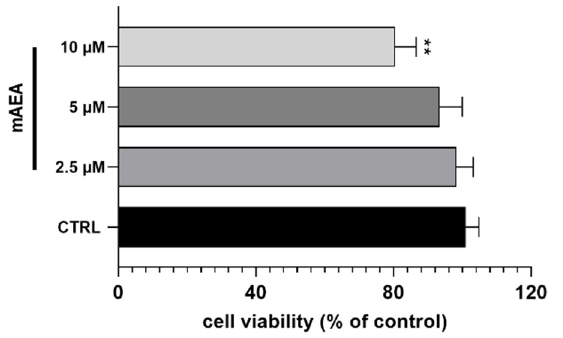
Figure 7. Assessment of cell viability using MTT assay on C2C12 myoblasts treated with mAEA at different doses (2.5, 5.0 and 10 µ M) for 24 h. Values are expressed as % of control cells and presented as mean ± SEM of three independent experiment ( n = 3). Statistical analysis was performed by ONE-WAY ANOVA followed by Bonferroni post-hoc test [** p < 0.01 vs. control cells (CTRL)].